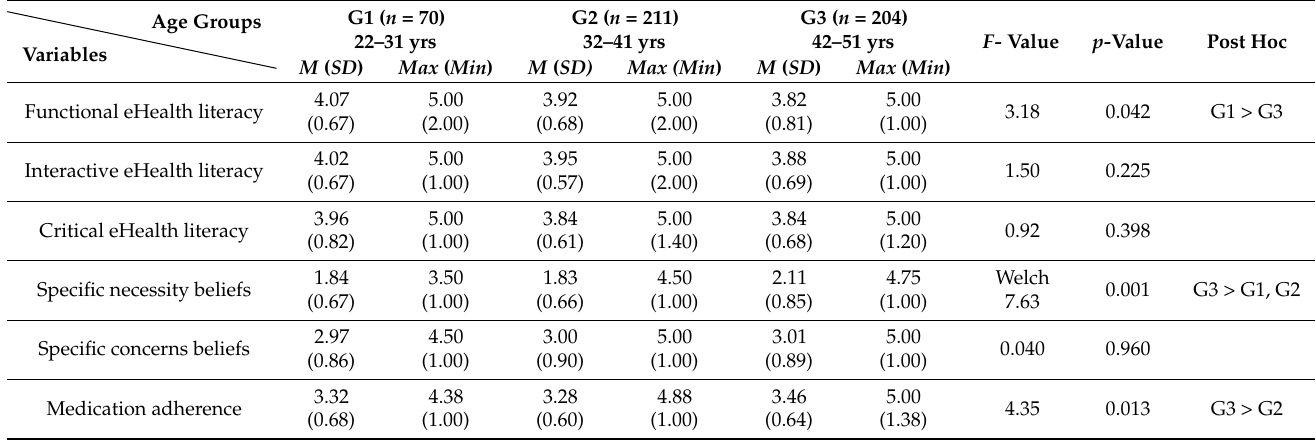
Table 2. Overview of the mean (and standard deviation in parentheses) and max (and min in parentheses) values and one-way ANOVA results of the participant characteristics, with stratification by age.